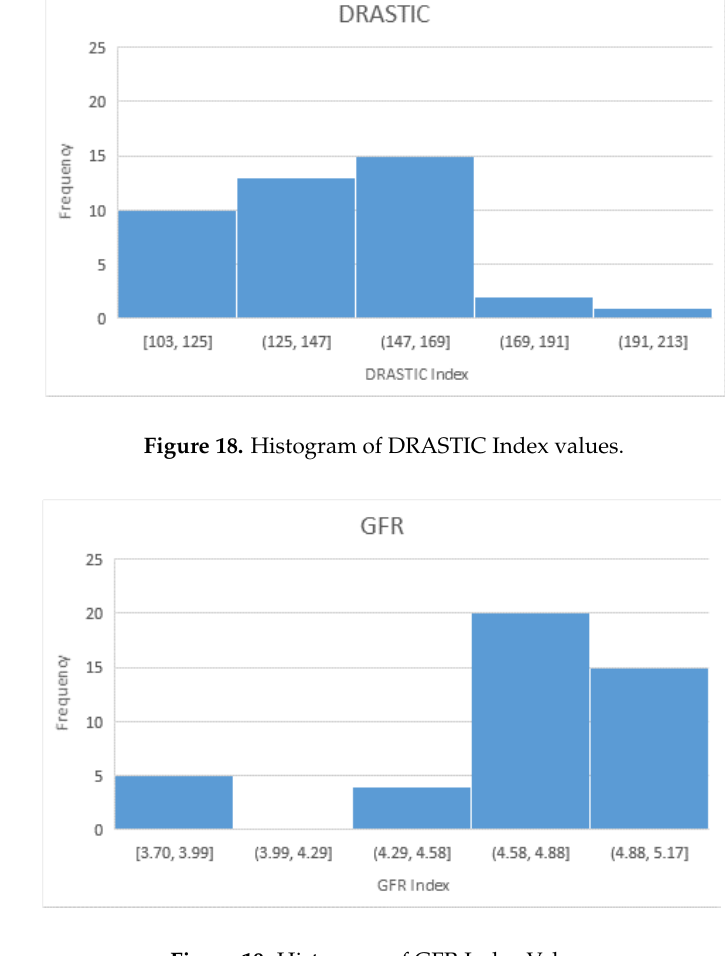
Figure 19. Histogram of GFR Index Values. Table 7. Natural Breaks classification of DRASTIC and GFR Index.